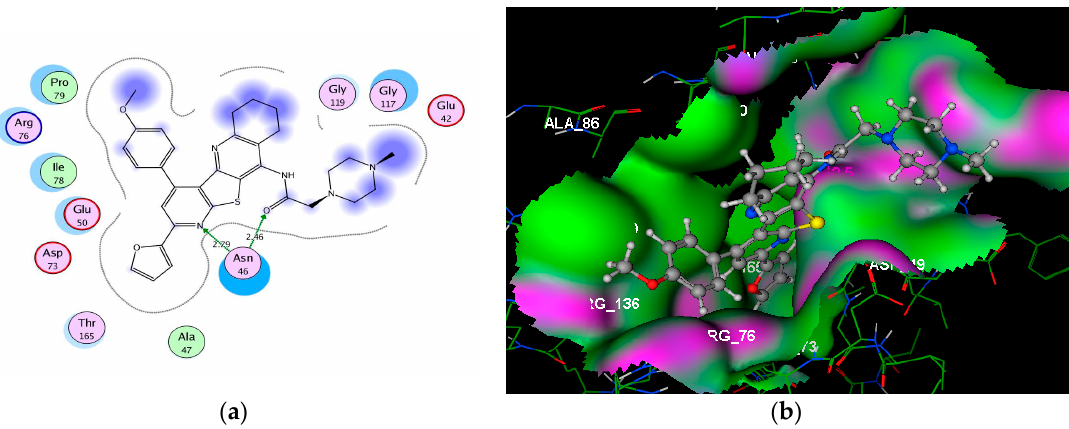
Figure 4. 2D ( a ) and 3D ( b ) diagrams illustrating the binding patterns of compound 4a into the ATP- active pocket of E. coli DNA gyrase B (PDB code: 1AJ6).